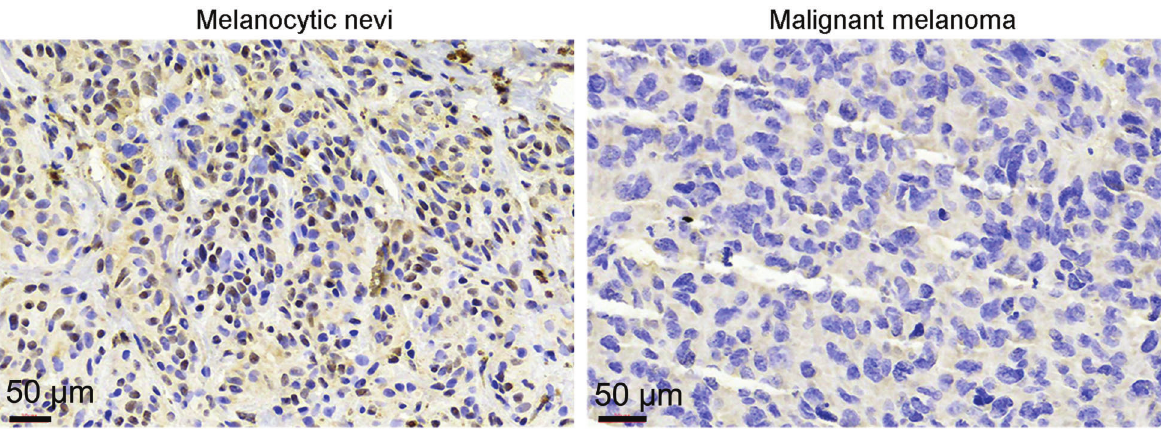
Figure 1. Expression level of nucleolar protein 14 (NOP14) in malignant melanoma tissues and melanocytic nevi tissues. Scale bar: 50 m m.